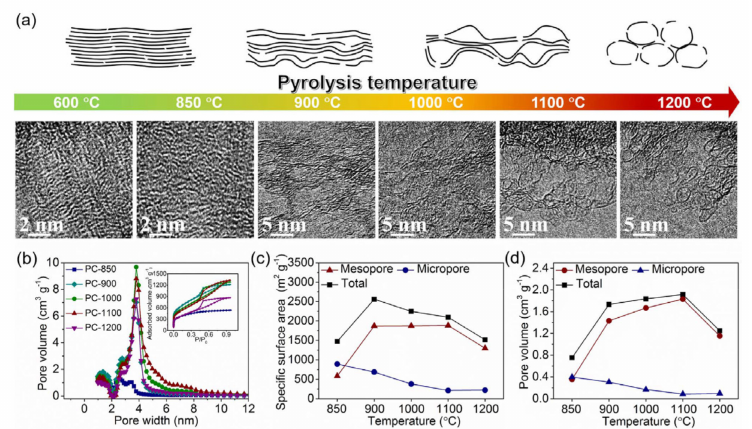
Figure 2. ( a ) Effect of temperature on porous formation illustrated by TEM images. ( b ) Nitrogen adsorption–desorption isotherms (inset) and pore size distributions of ACs. ( c ) S BET and ( d ) pore volume of ACs [36]. Figure reproduced with permission from Elsevier, 2017.